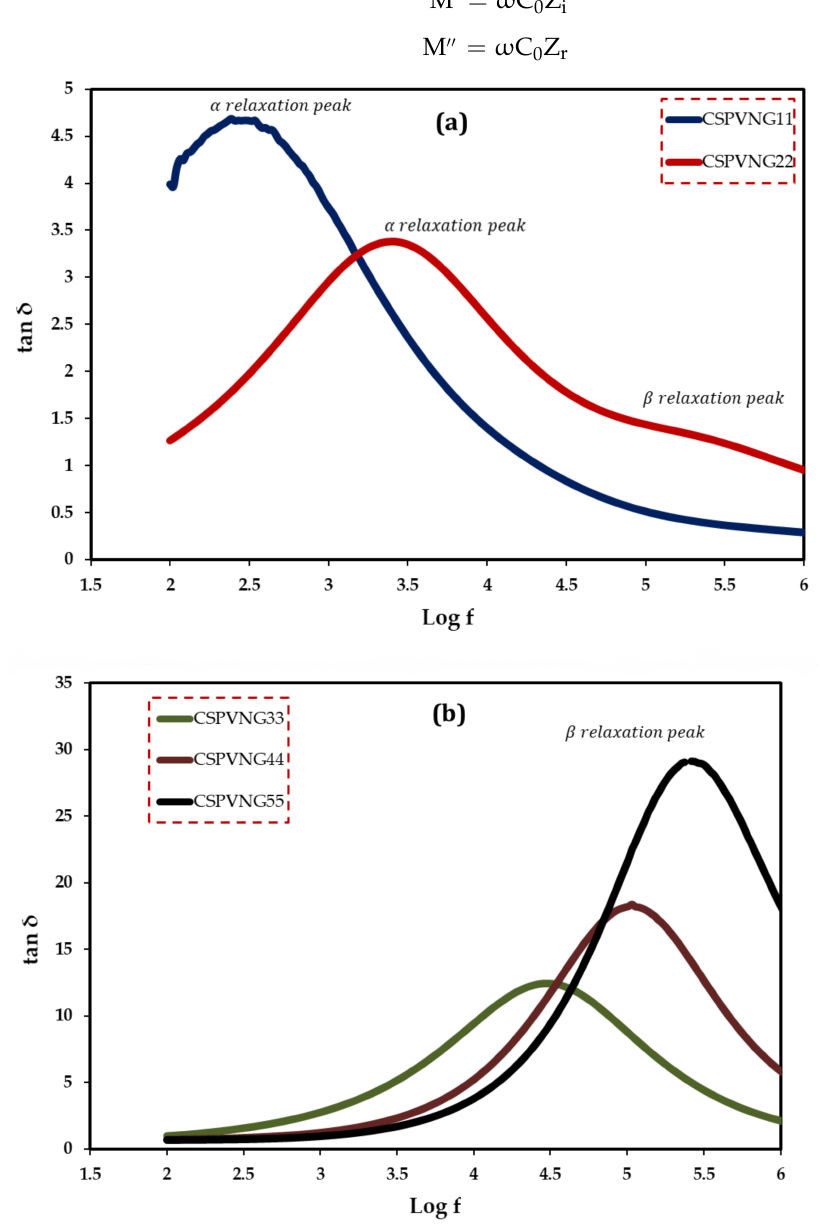
Figure 11. Loss tangent versus log (f) for ( a ) CSPVNG11 and CSPVNG12, and ( b ) CSPVNG33, CSPVNG44 and CSPVNG55 the electrolyte